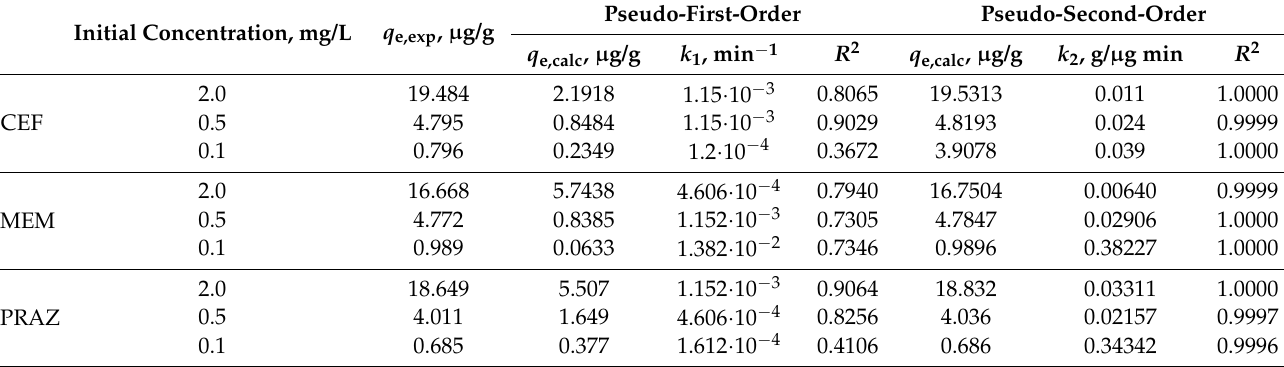
Table 5. Sorption kinetic parameters of pharmaceuticals for soil